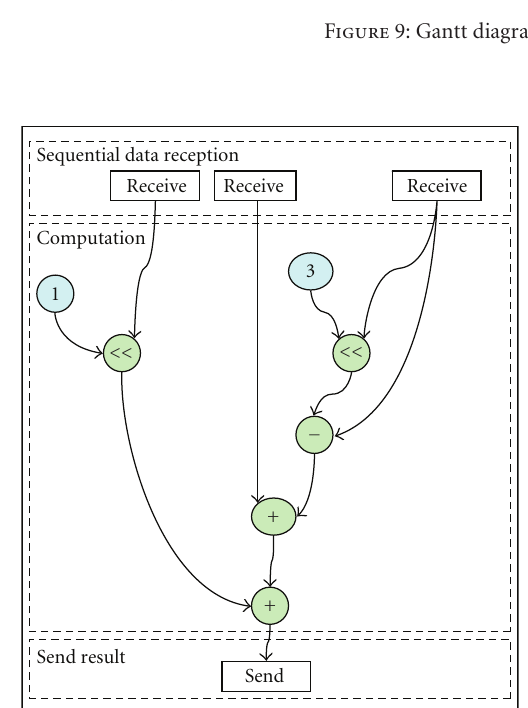
Figure 10: Application is an FIR filter function connected to input and output address generators (not represented on this figure).